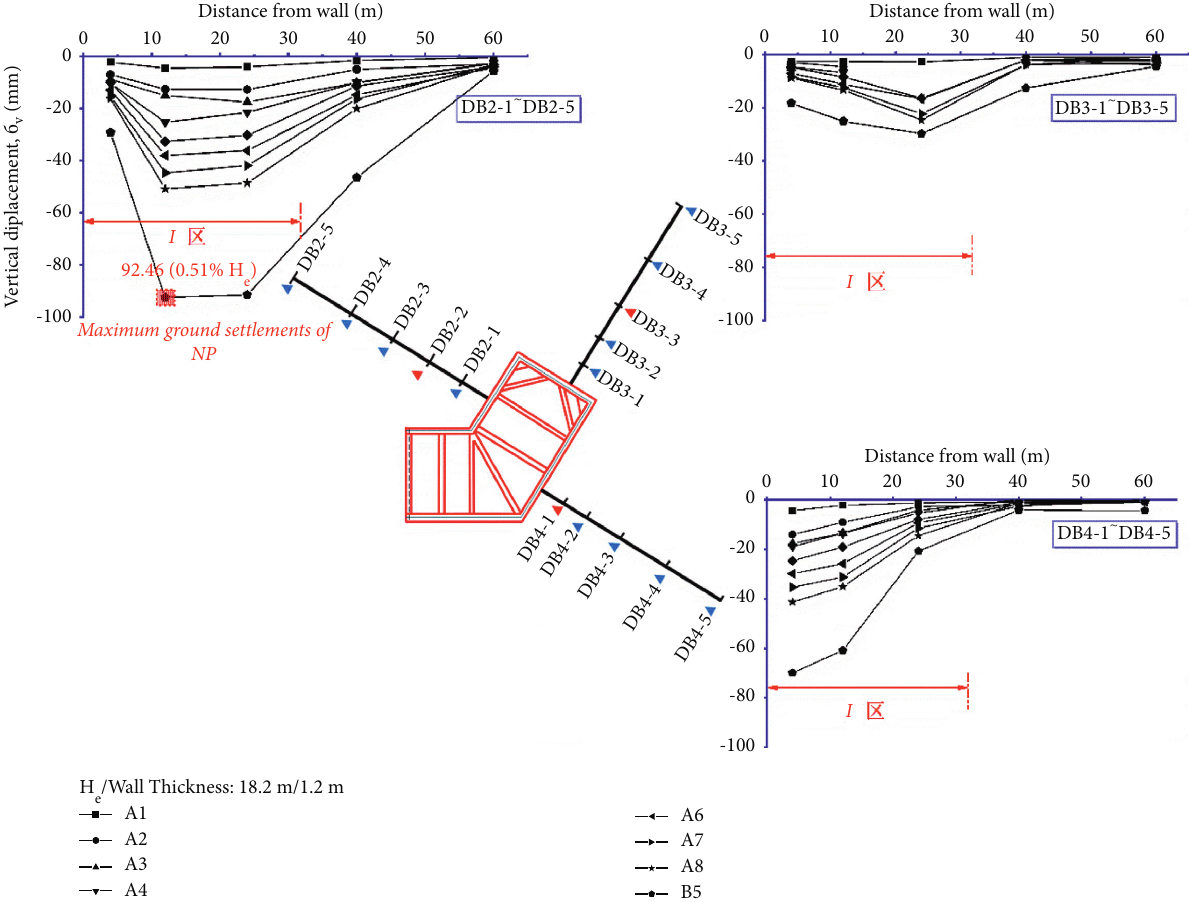
Figure 11: Ground surface settlements of